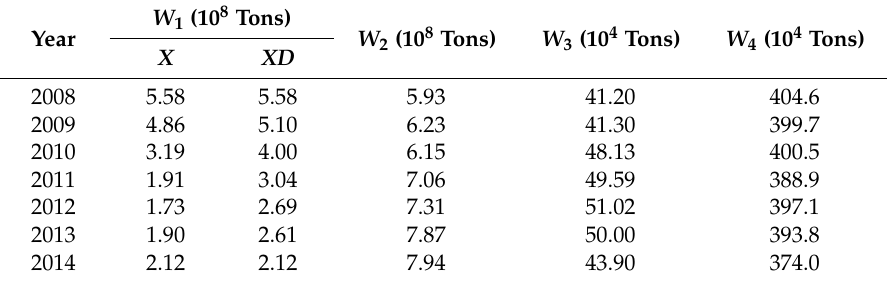
Table 1. Annual emissions of main water pollutants in the Three Gorges Reservoir Area between 2008 and